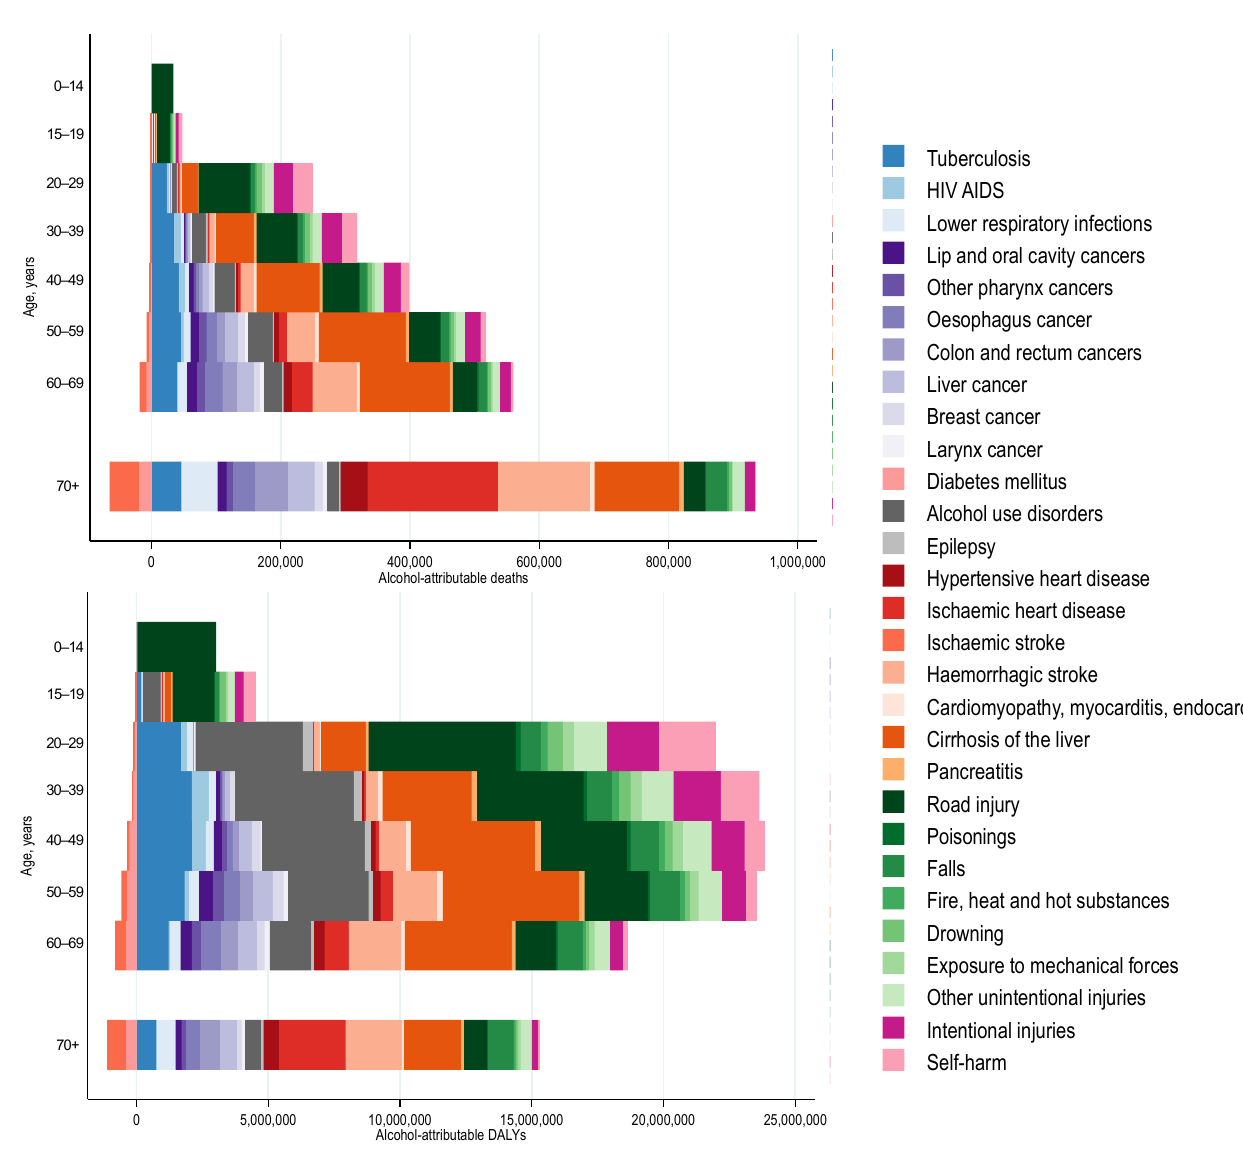
Figure 1. Alcohol-attributable deaths and disability adjusted life years (DALYs) lost by age.